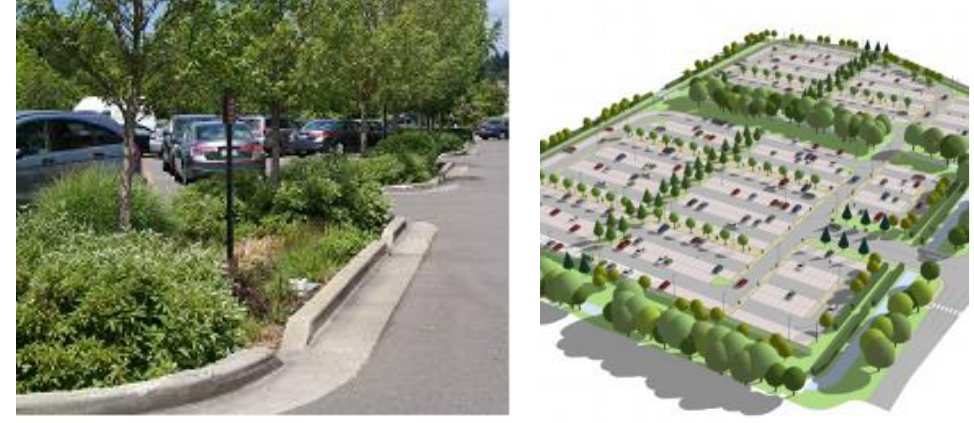
Figure 9. Grass gardens in the parking space (https://www.sllistbeograd.rs/pdf/2019/110-2019.pdf, accessed on 28 August 2022).